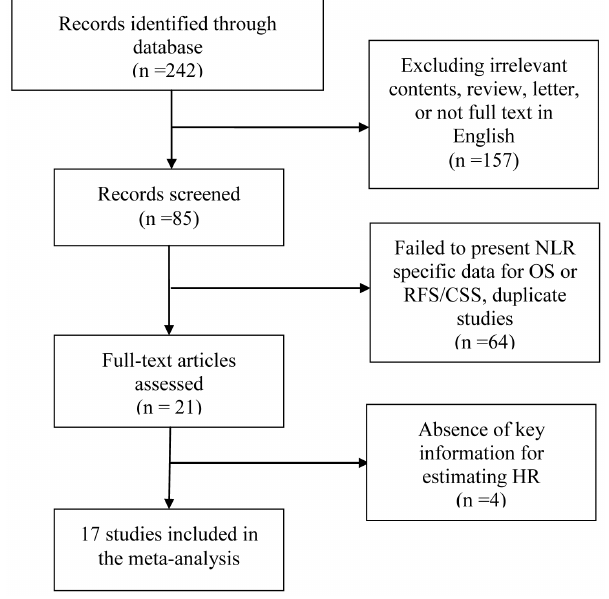
Figure 1. Methodological flow diagram of the meta-analysis.